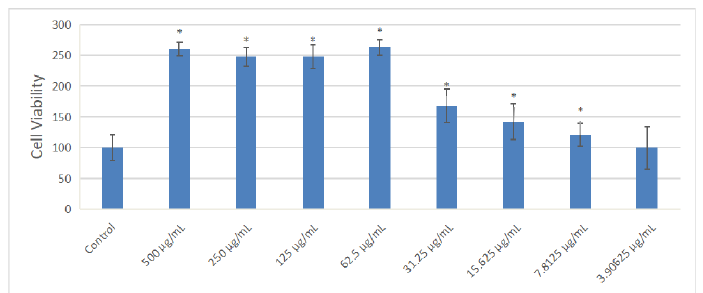
Figure 9. Effect of osmanthus fragrans extract on cell viability of MC3T3-E1. Different concentrations of osmanthus extract were co-cultured with MC3T3-E1 cells for 72 h, and cell viability was detected by CCK-8 assay: *, p < 0.05 compared with control group.